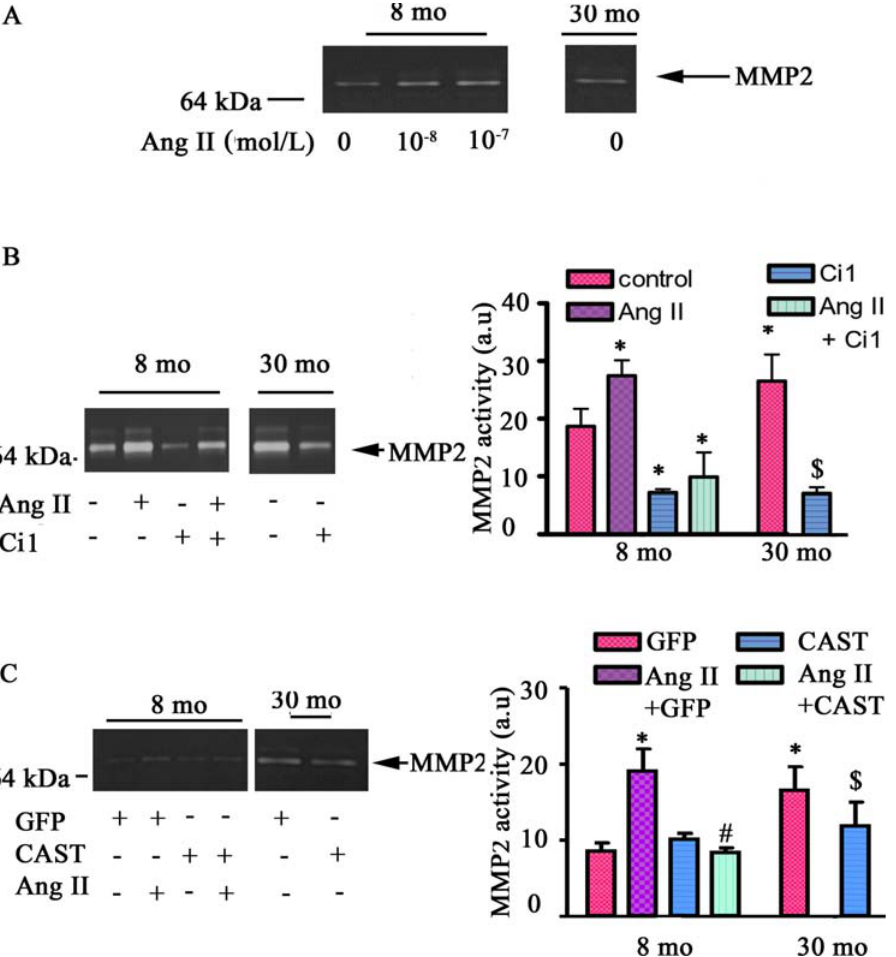
Figure 5. Ang II induces activity of MMP2 mediated by calpain-1 activation. A. A representative PAGE gelatin zymogram from young and old VSMC treated with Ang II for 48 hrs. B. A representative PAGE gelatin zymogram of VSMC treated with Ang II, or Ci 1, a calpain inhibitor, for 48 hrs (left panel); average data (right panel). C. A representative PAGE gelatin zymogram of VSMC infected adenovirus harboring GFP or CAST treated with Ang II (left panels); average data (right panel). *p , 0.05, vs. young untreated VSMC (control). # p , 0.05, vs. Ang II treated young VSMC. $p , 0.05, vs. old untreated VSMC.